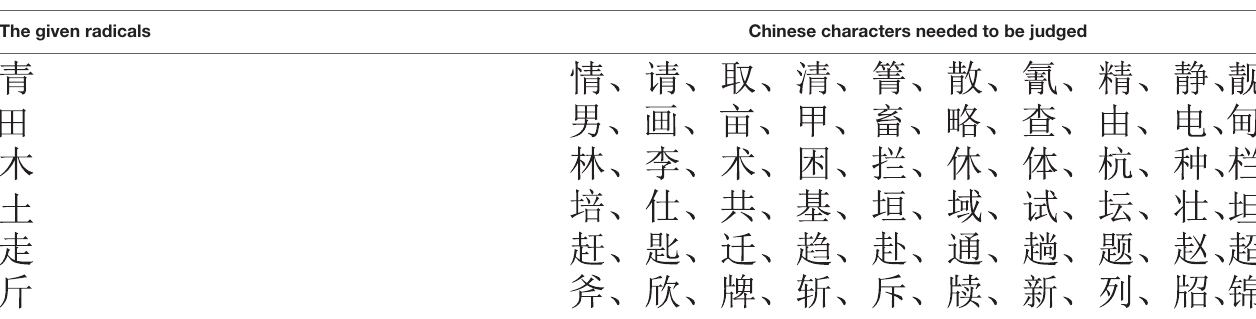
TABLE 2 | Stimuli in the Chinese characters recognition